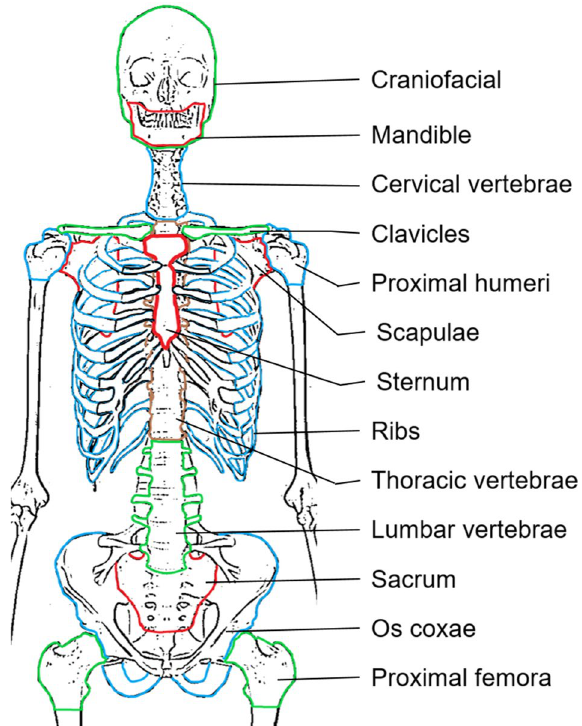
Fig. 2 Schematic image of the 13 skeletal sites used to calculate S-values in this study